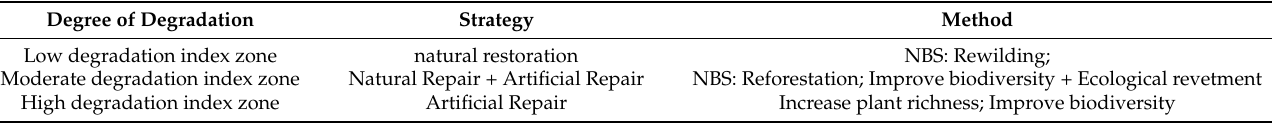
Table 4. Ecological restoration methods for different degraded